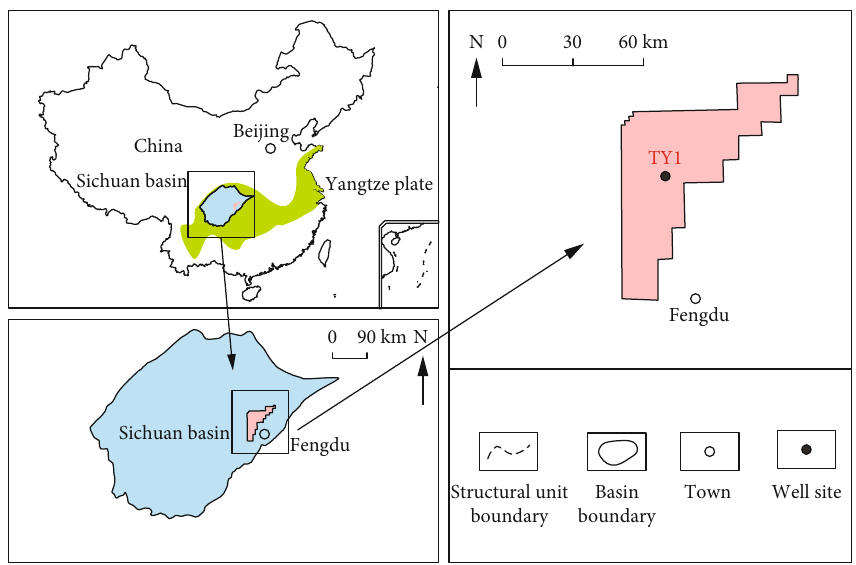
Figure 1: Locations of southeastern Sichuan Basin in South China and TY1 well